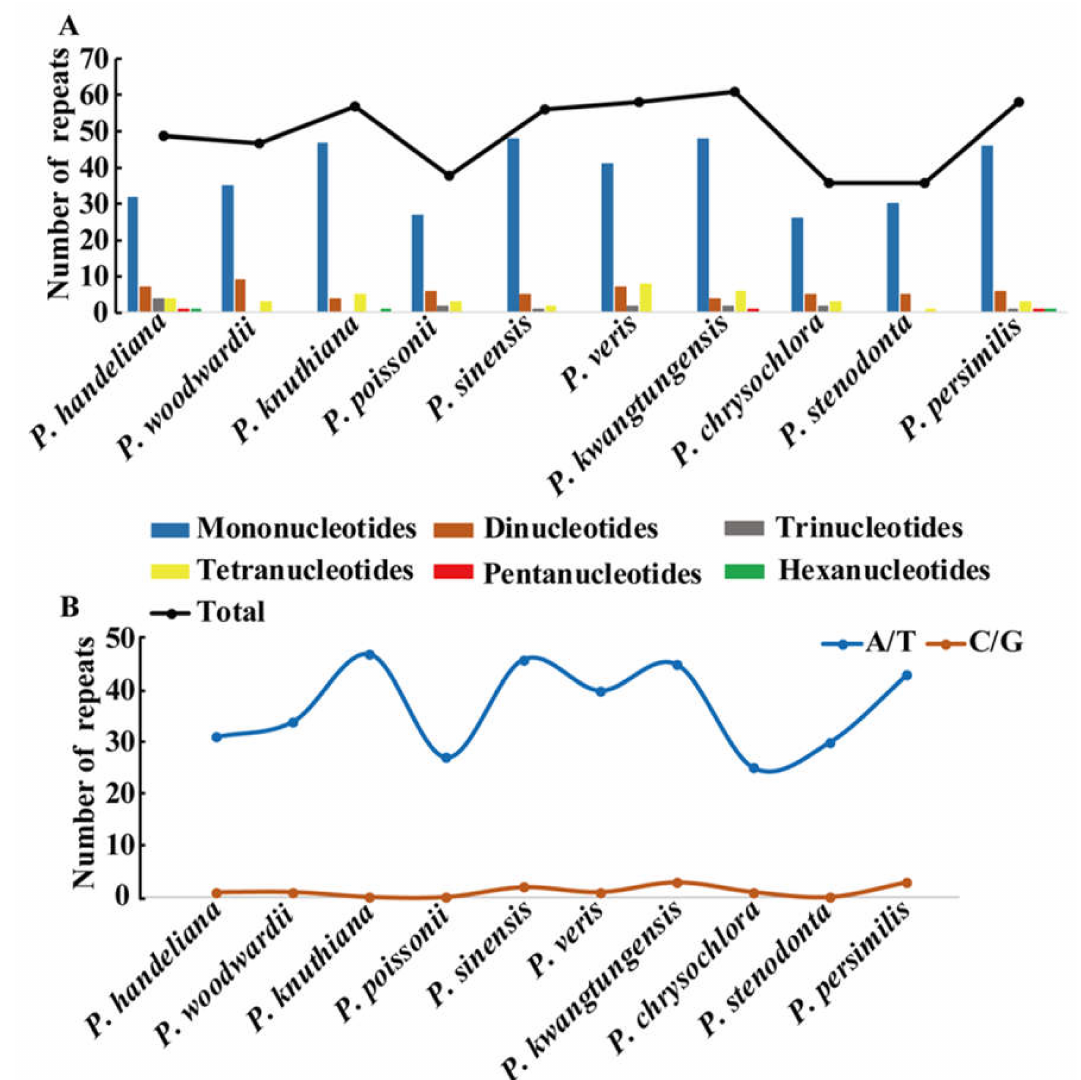
Figure 2. Simple sequence repeats (SSRs) in the 10 Primula plastid genomes. ( A ) Number of SSR types; ( B ) number of mononucleotide A/T and G/C